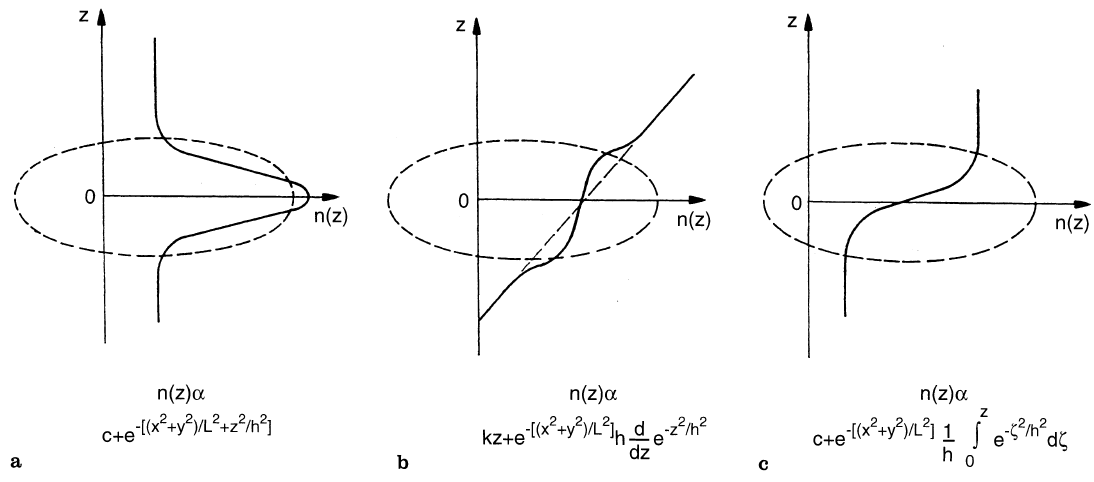
Fig. 4a–c. More detailed representations of the average shapes of radio-wave scatterers (from Hocking,